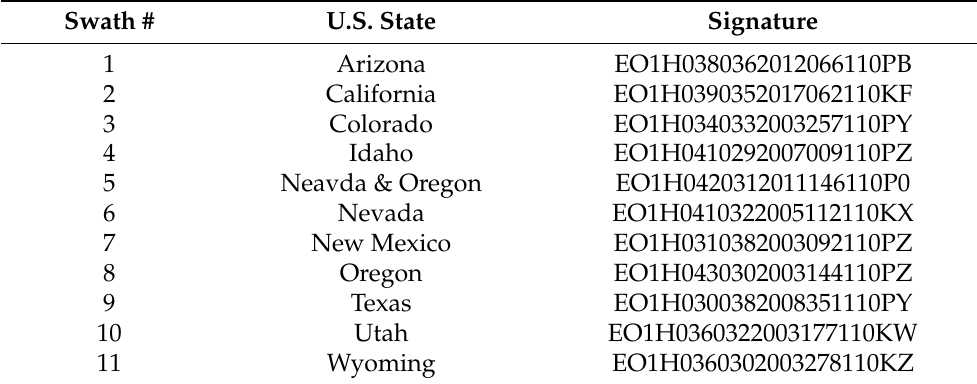
Figure 12. Bar graphs showing the accuracies ( top ) and F1-scores ( bottom ), in alphabetical order, of each of the three models for each of the chosen 11 swaths for shrub soil arsenic risk analysis. Numbers below bars correspond to swaths in Figure 11. Table 7. NASA-designated signatures, along with the U.S. state, of the 11 swaths used in shrubland arsenic